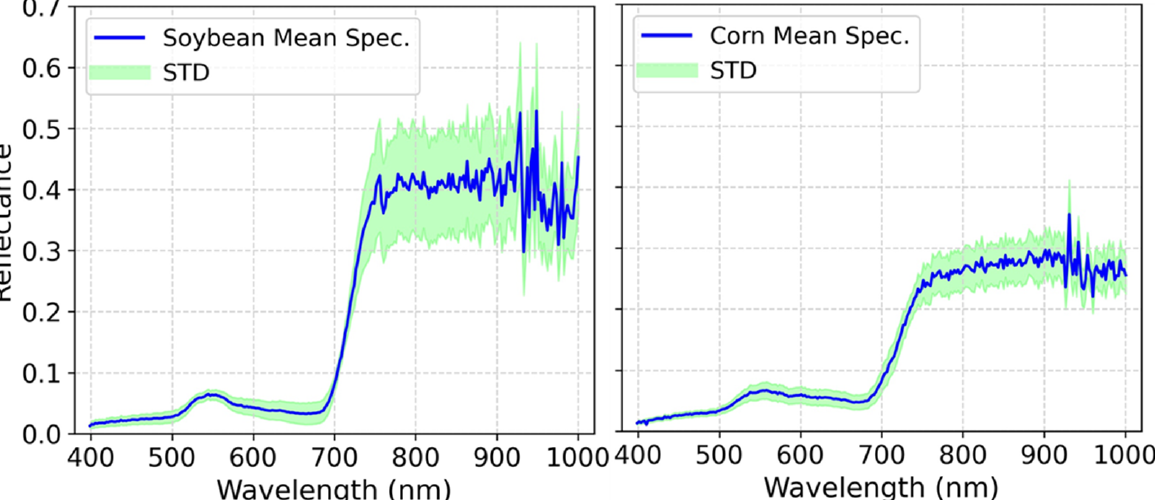
Figure 4. The mean and standard deviation (STD) of reflectance values of each wavelength band for soybean plots and corn plots.